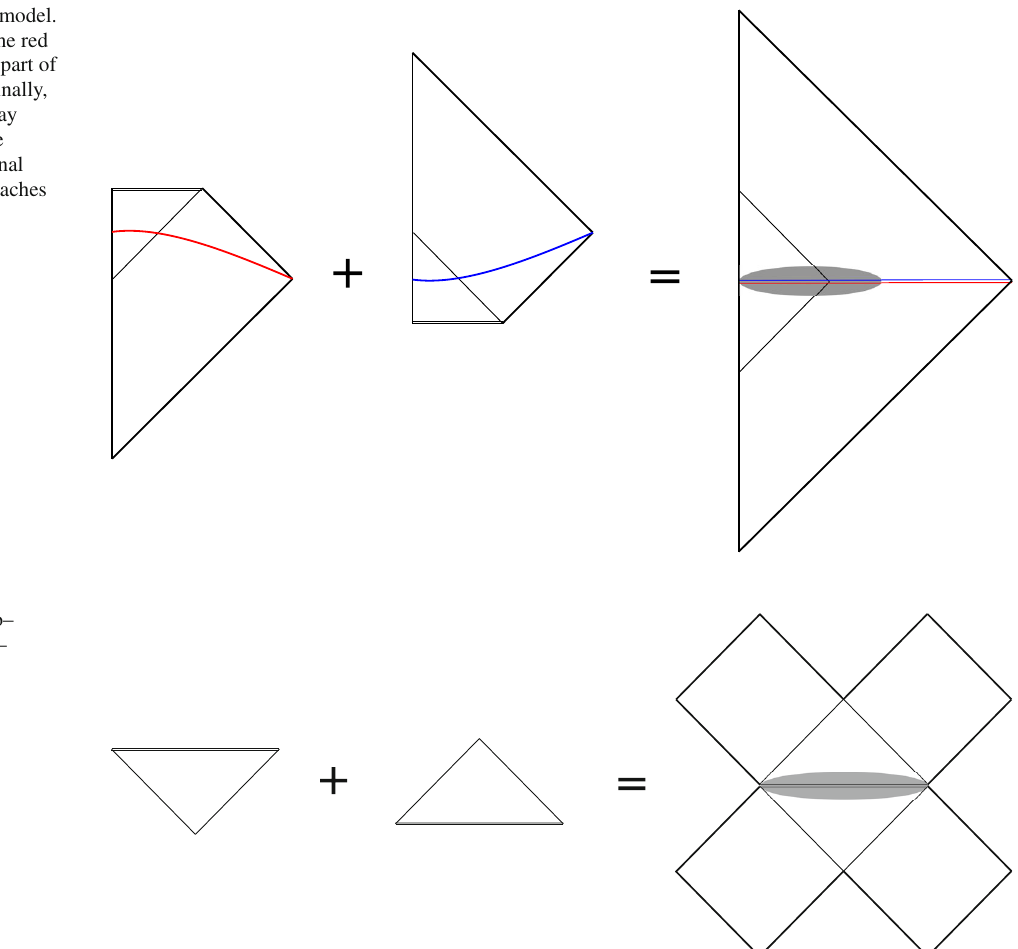
Fig. 7 Ashtekar–Olmedo– Singh/Bodendorfer–Mele– Munch